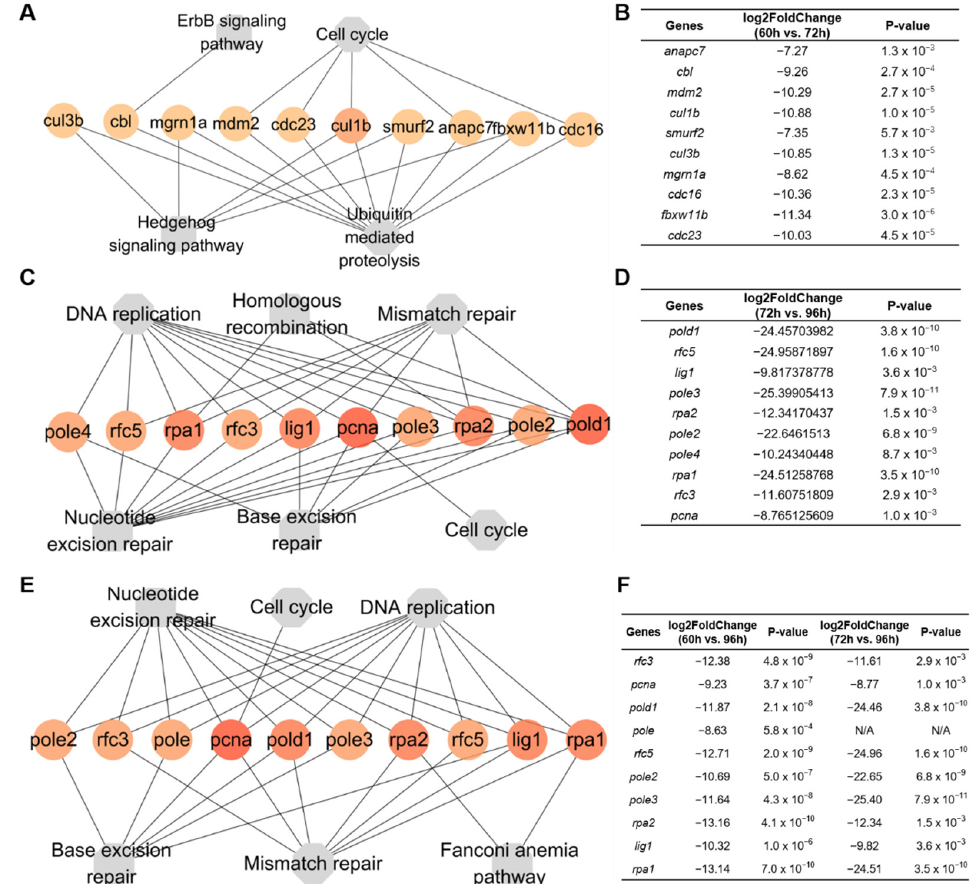
Figure 6. Hub genes within KEGG pathways. ( A ) Networks of 10 hub genes mapped to top four pathways in groups a and b from 60 to 72 hpf. ( B ) The fold changes of hub genes in groups a and b. ( C ) Networks of 10 hub genes mapped to top 6 pathways from 72 to 96 hpf in groups f and g. ( D ) The fold changes of hub genes in groups f and g. ( E ) Networks of 10 hub genes mapped to top 6 pathways from 60 to 96 hpf in groups c, f, and g. ( F ) The fold changes of hub genes in groups c, f, and g.